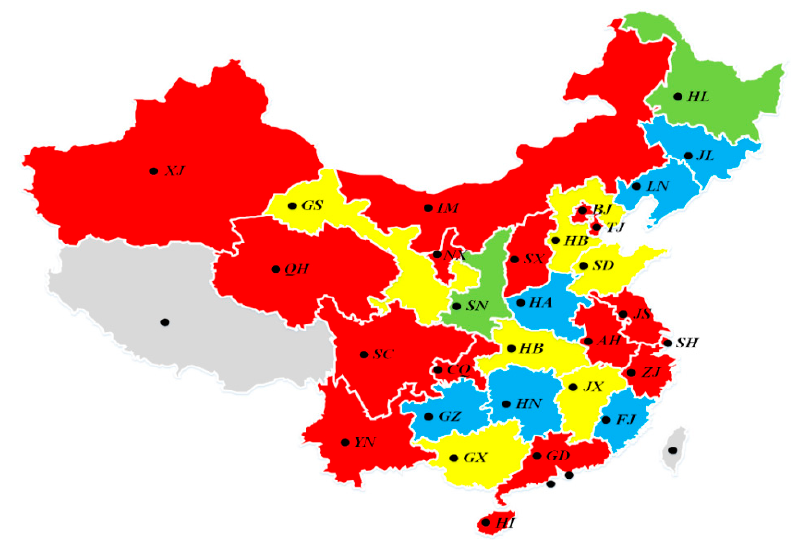
Figure 6. Clustering map of industrial enterprises’ green innovation comprehensive efficiency in China.